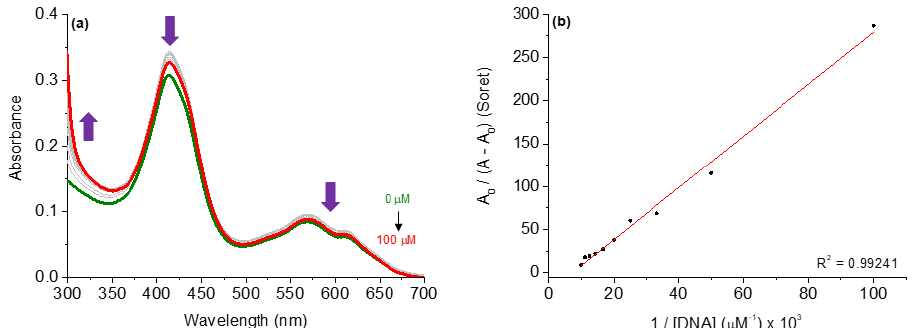
Figure 5. ( a ) UV-Vis spectra of the corrole 4 upon successive additions of CT-DNA concentrations (0 to 100 µM) in DMSO(5%)/Tris-HCl pH 7.4 mixture buffered solution. ( b ) Benesi-Hidelbrandt plots of A 0 /(A − A 0 ) vs. 1/[CT-DNA]. Table 5. DNA-binding properties of corroles 1 – 4 by UV-Vis and fluorescence emission analysis. UV-Vis